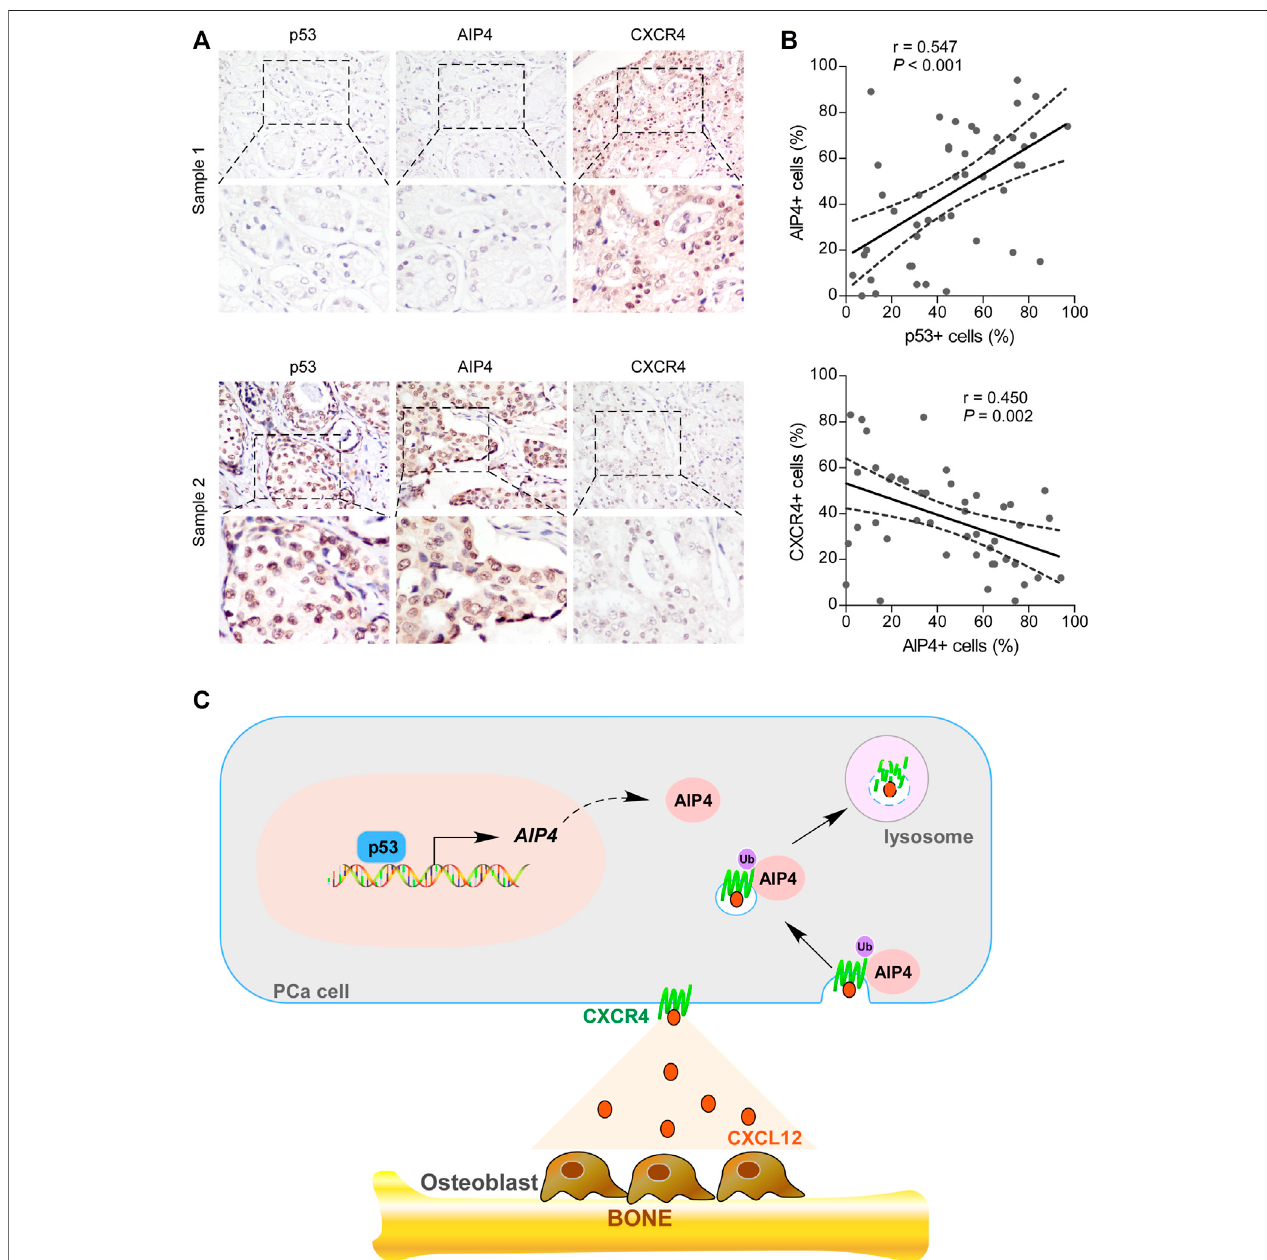
FIGURE6| Theexpressionofwt-p53,AIP4,andCXCR4wereclinicallyrelevantinhumanprostatecancer. (A) Representativeimagesofwt-p53,AIP4,andCXCR4 staininginprostatecancerpatientspecimens.Tworepresentativecasesareshown.Originalmagni fi cation,uppanel: × 200;down panel:inset. (B) Pearson ’ scorrelation analysis of protein expression between genes based on IHC data of prostate cancer specimens. (C) Model: p53 transcriptionally activates the downstream ubiquitin ligaseAIP4topromotedegradationofthechemokinereceptorCXCR4,andthusblocksthetraf fi ckingofCXCR4-positiveprostatecancercellstothebonemarrow.